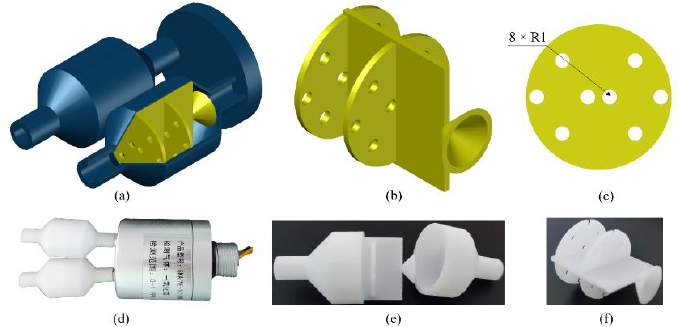
Figure 5. Electronic nose bionic nasal chamber: ( a ) three-dimensional model, ( b ) bionic partition in chamber, ( c ) single sieve plate in bionic partition, ( d ) physical picture of electronic nose, ( e ) physical picture of single bionic nasal chamber, and ( f ) physical picture of bionic baffle.